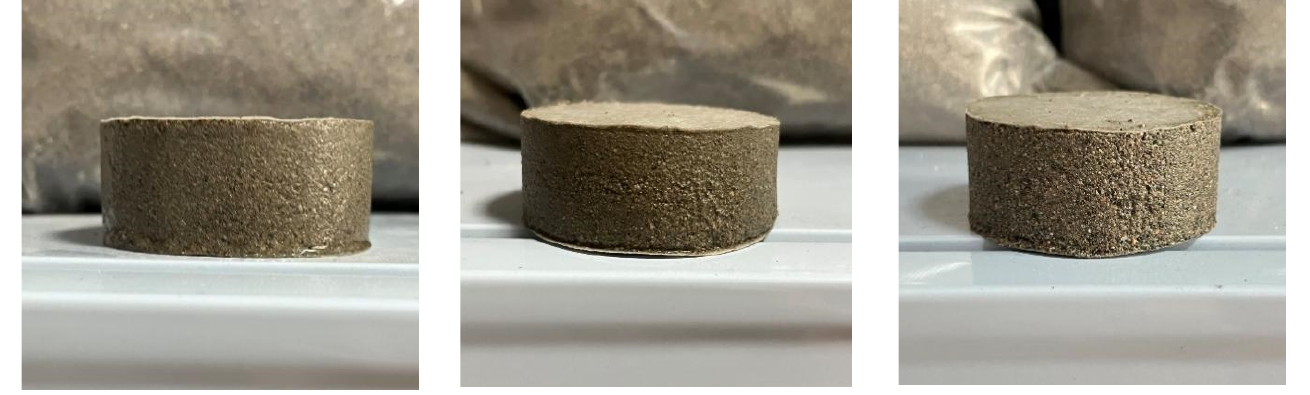
Figure 20. Morphology of the specimen after damage.